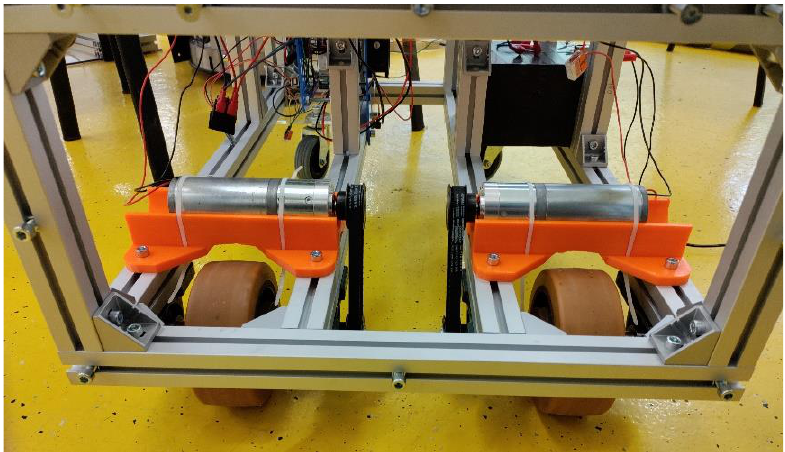
Figure 7. Transmission of torques from electric motors with gearboxes to drive wheels.